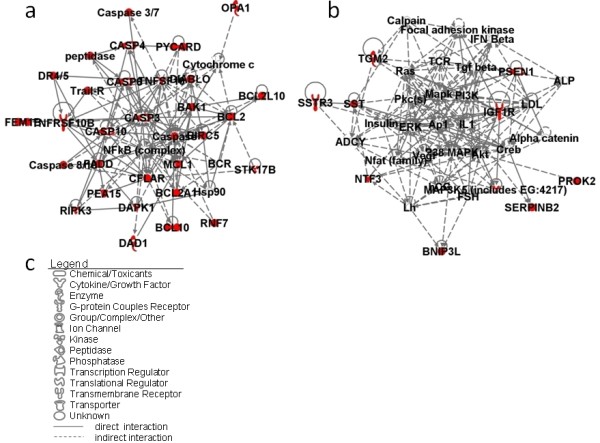
Network pathway analysis of upregulated genes in the gene category regulation of apoptosis. (a) Network 1 and (b) Network 2 constructed by 42 upregulated genes. (c) Network graphical representation. Genes or gene products are represented as individual nodes whose shapes represent the functional class of the gene products. The biological relationship between the two nodes is represented as an edge (line). All edges are supported by at least one reference from the literature stored in the Ingenuity Pathways Knowledge Base (IPKB). Genes with colored nodes were found over-represented in the gene category regulation of apoptosis. Genes with uncolored nodes were not found over-represented, but were depicted by computationally generated networks on the basis of evidence stored in the IPKB, indicating strong biologic relevance to that network.